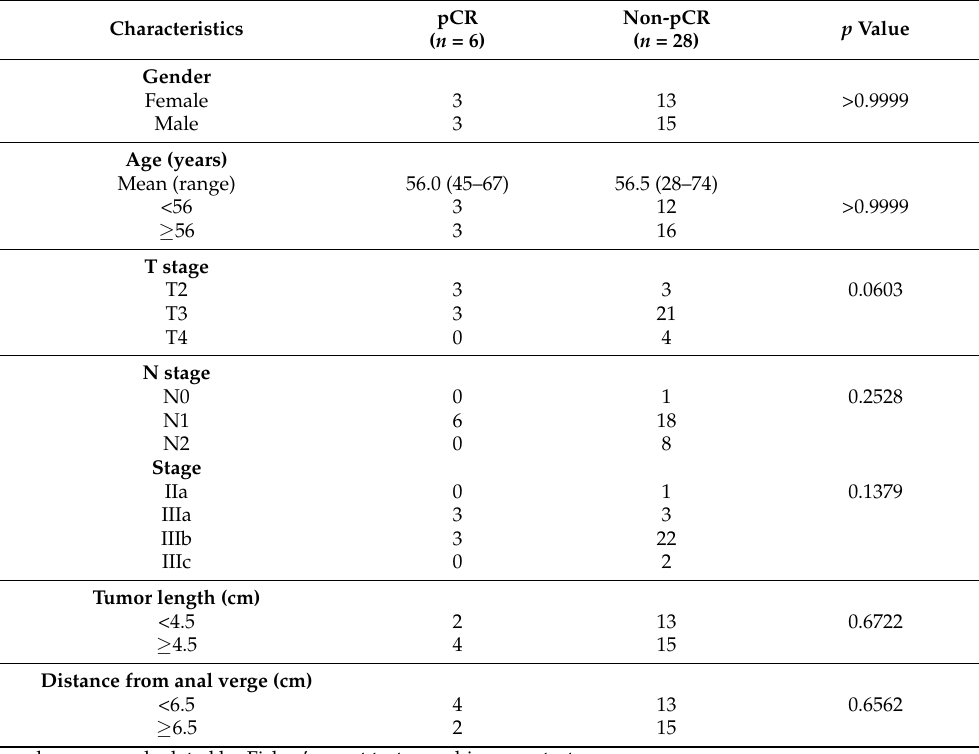
Table 2. Subject characteristics in the pretreatment LARC